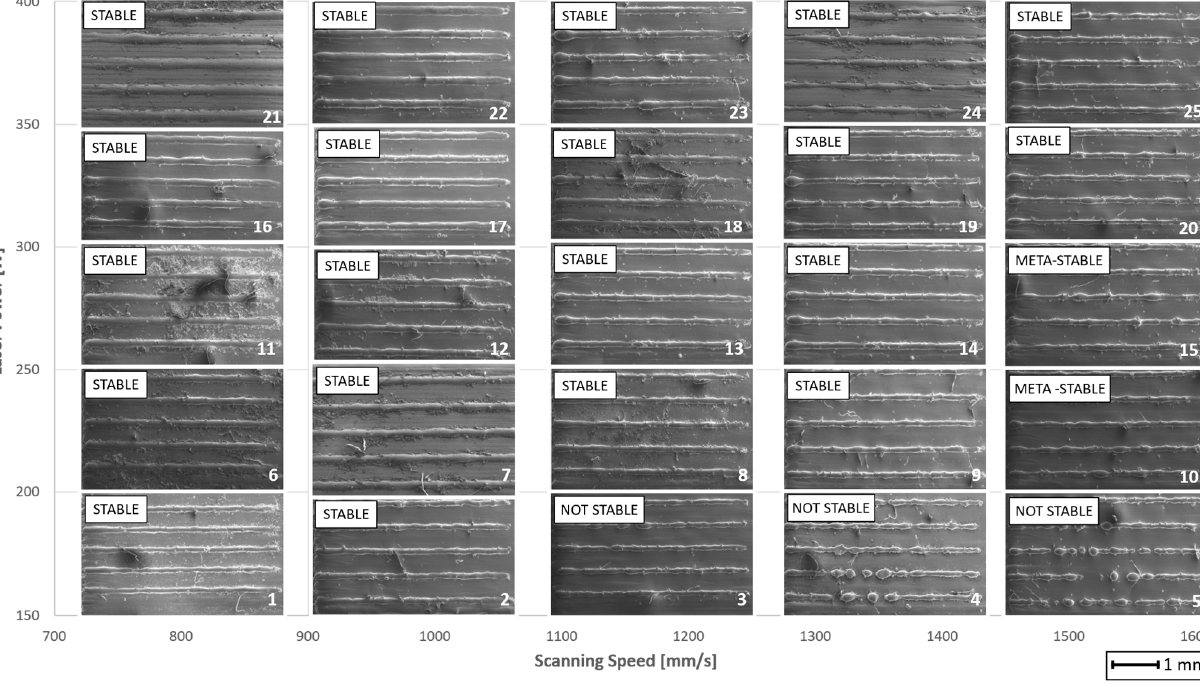
Figure 13. Track stability map (number in white indicate the sample). Table 4. Track’s stability tracking